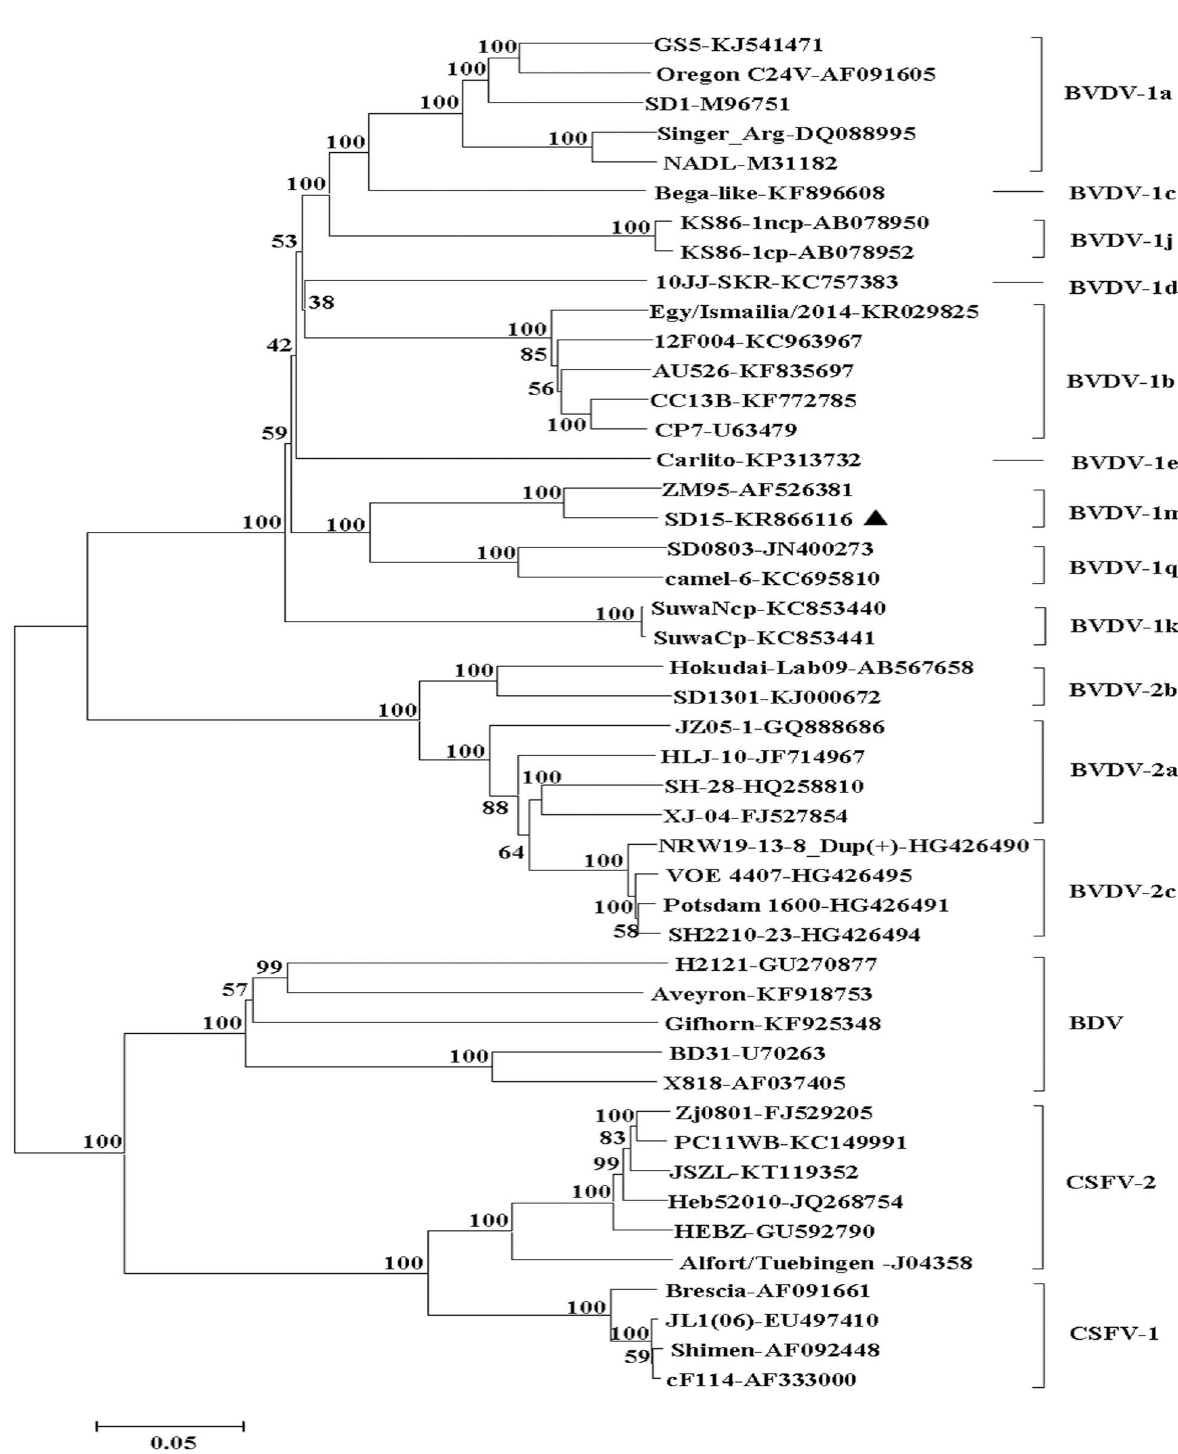
PLOS ONE | DOI:10.1371/journal.pone.0165044 October 20,